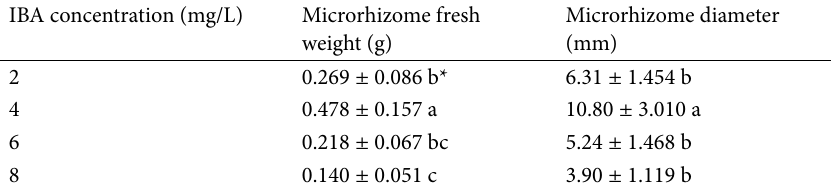
Table 6 Effect of IBA (indole-3-butyric acid) concentrations on microrhizome growth. IBA concentration